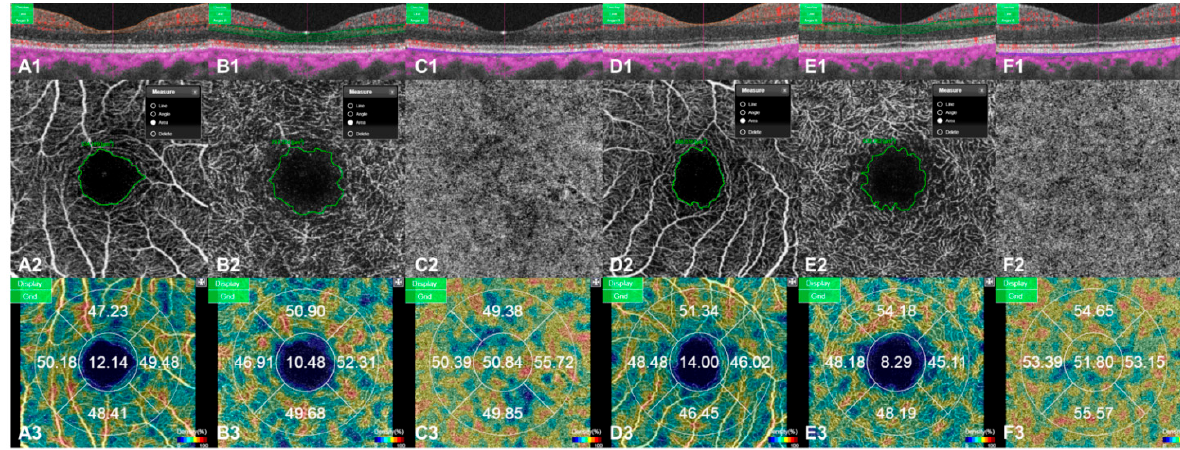
Figure 3. Measurements of the foveal avascular zone (FAZ) area and capillary vessel density (VD) were conducted using swept-source optical coherence tomography angiography (SS-OCTA). En face images were generated for retinal vascular networks: superficial capillary plexus (SCP), deep capillary plexus (DCP), and choriocapillaris (CC), after spontaneous resolution of subretinal fluid (SRF) 1 month later ( A1–C3 ), and in unaffected fellow eyes ( D1–F3 ). The cross-sectional scans show the corresponding segmentation layers and intact inner or outer segment junction ( A1–F1 ). The FAZ area was defined as the area inside the central border of the capillary network and determined by manually outlining the inner border of foveal capillaries using the OCTA system software ( A2,B2,D2,E2 ). The VD maps consisted of concentric circles with diameters of 1 and 3 mm. Foveal and parafoveal VDs of SCP, DCP, and CC were measured automatically ( A3–F3 ).